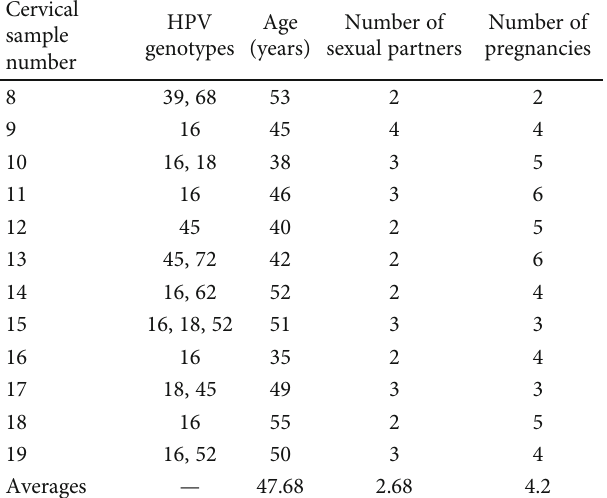
Table 2: Clinical data of patients with di ff erent cervical squamous cell